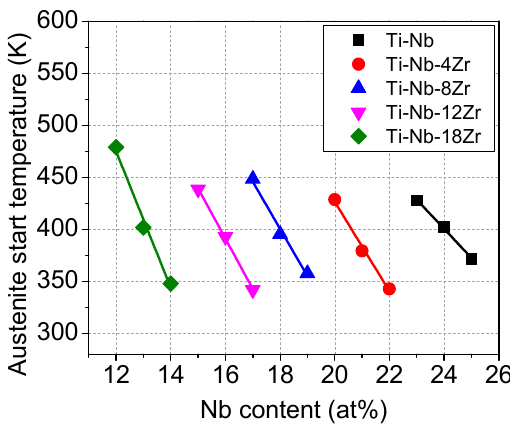
Figure 9. Nb content dependence of the As temperature for Ti–Nb and Ti–Nb–Zr alloys.